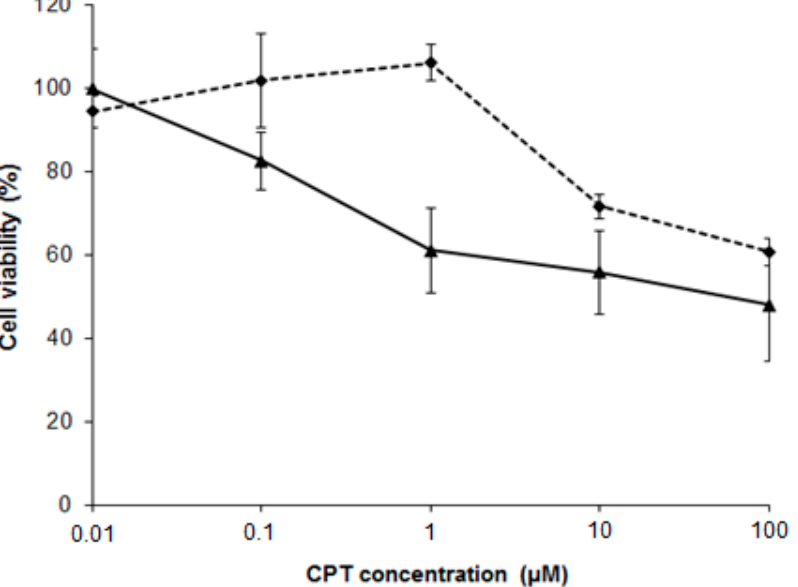
Figure 8. NSC pretreatment improves the cytotoxic effect of camptothecin on PC-3 cells. Cells were pretreated with 100 µM NSC for 10 min (solid line) or untreated (dashed line), washed, and further exposed to camptothecin at different concentrations for 48 h.